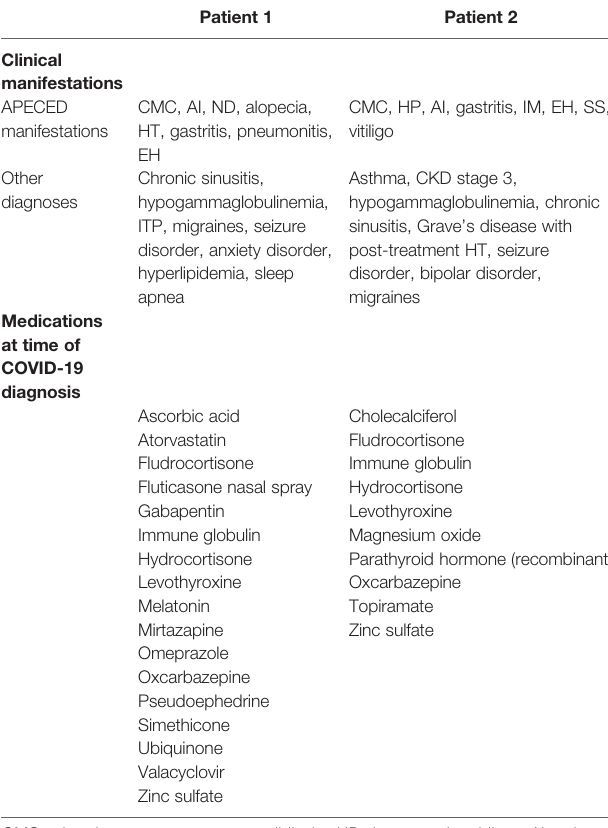
TABLE 1 | Clinical manifestations and medications of the APECED patients included in our